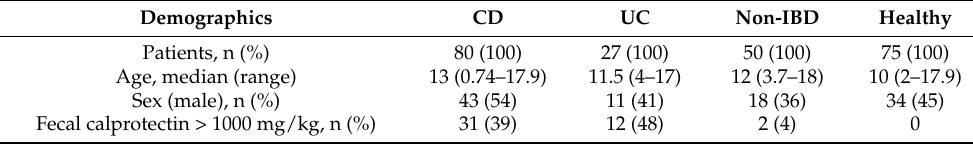
Table 1. Demographics showing diagnosis, age, sex and fecal calprotectin values.